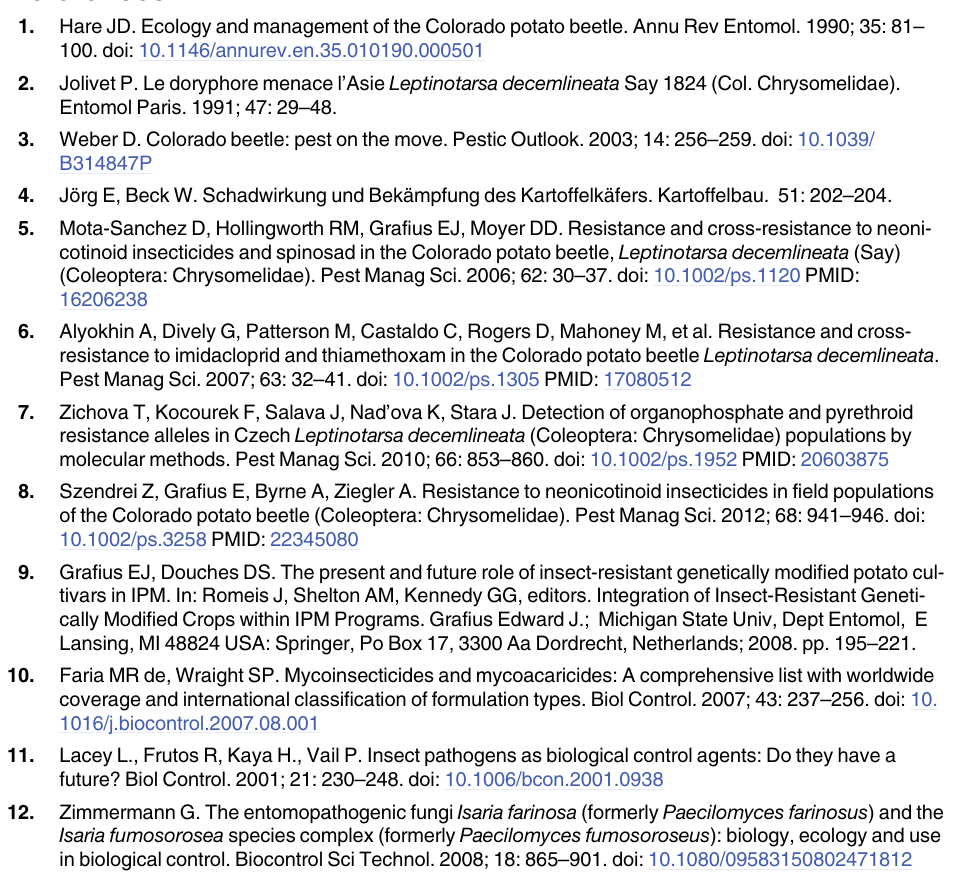
S6 Dataset. Table 6 original data. S7 Dataset. Fig 6, Table 7 original